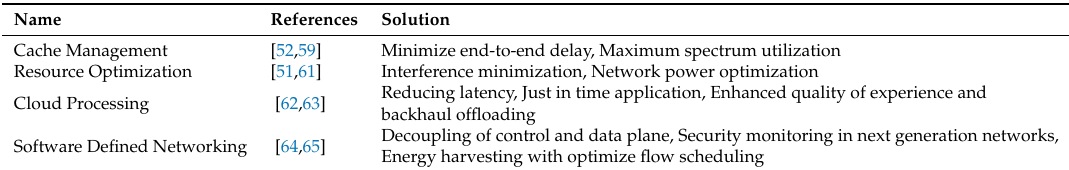
Table 3. Advantages of Big data Aware Next Generation